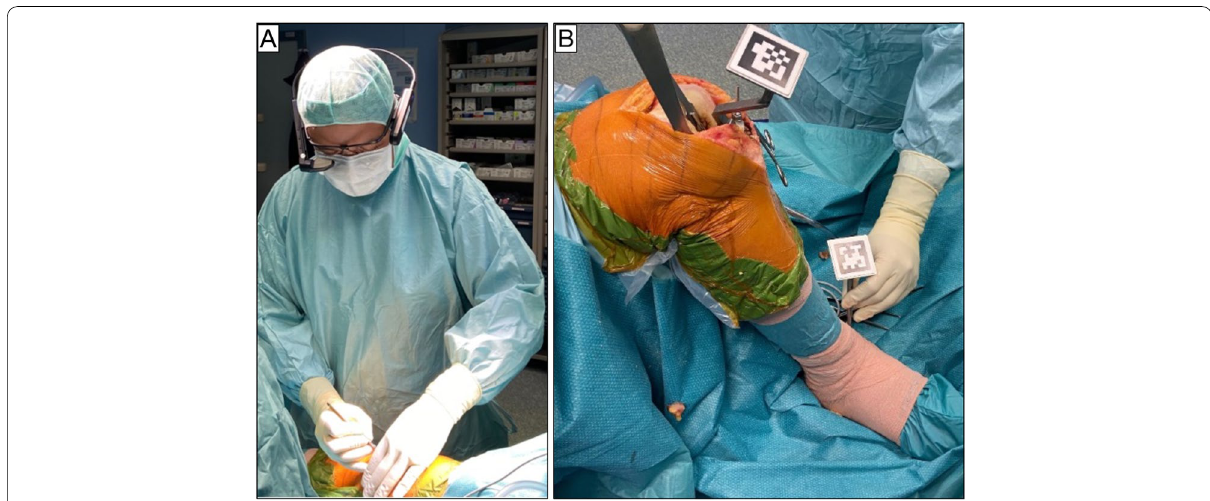
Fig. 2 A Smart glasses worn by surgeon during surgery. B The surgeon registers bone landmarks consisted of lateral and medial malleolus using the pointer with